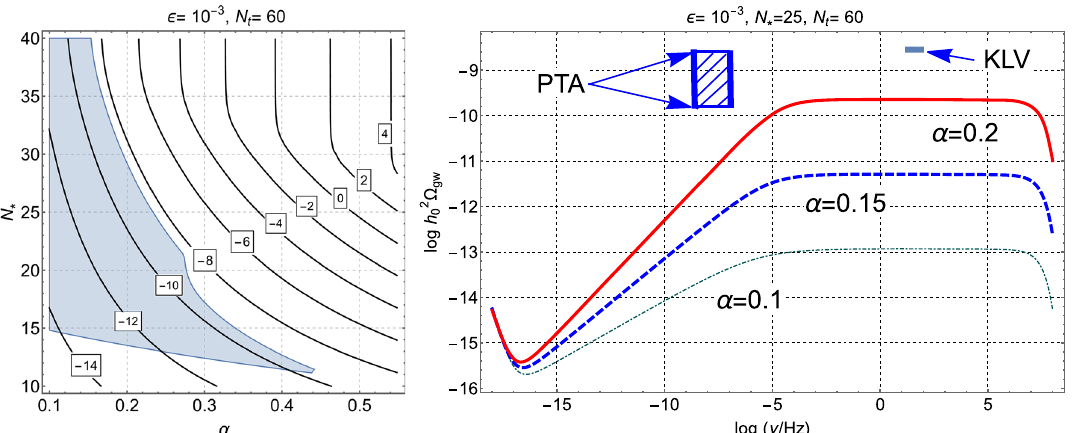
Fig. 4 The shaded area is obtained by imposing all the previous con- straints except for Eq. (24) which is instead replaced by the limit (cid:3) (ν ,τ ) < 3 . 4 ( 1 ) × 10 − 10 for ν h 2 g w ref 0 0 plot at the right a specific choice of the parameters. This result shows